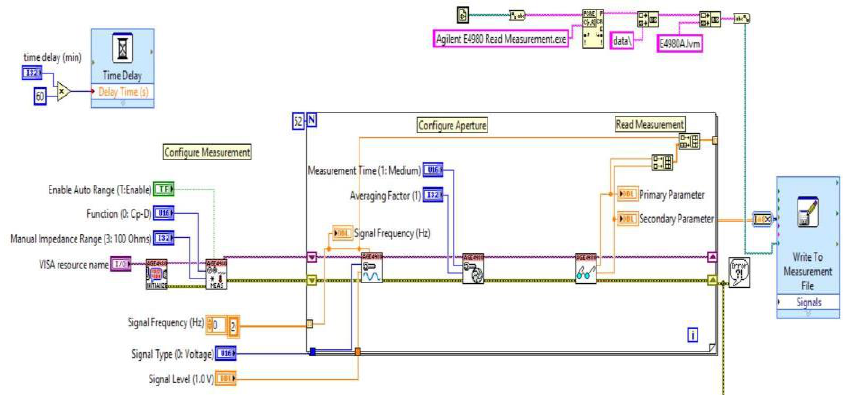
Fig. 1. Fragment block diagram of a program for measuring